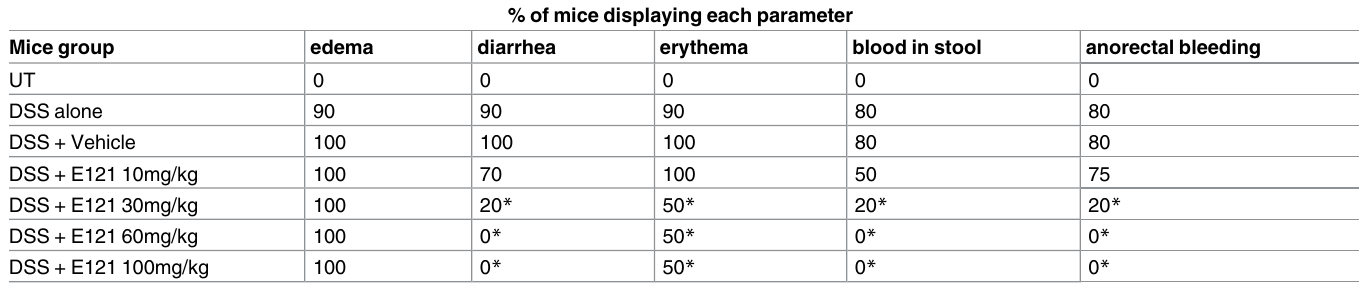
Table 1. Effect of E121 treatment on the macroscopic score for colitis severity.